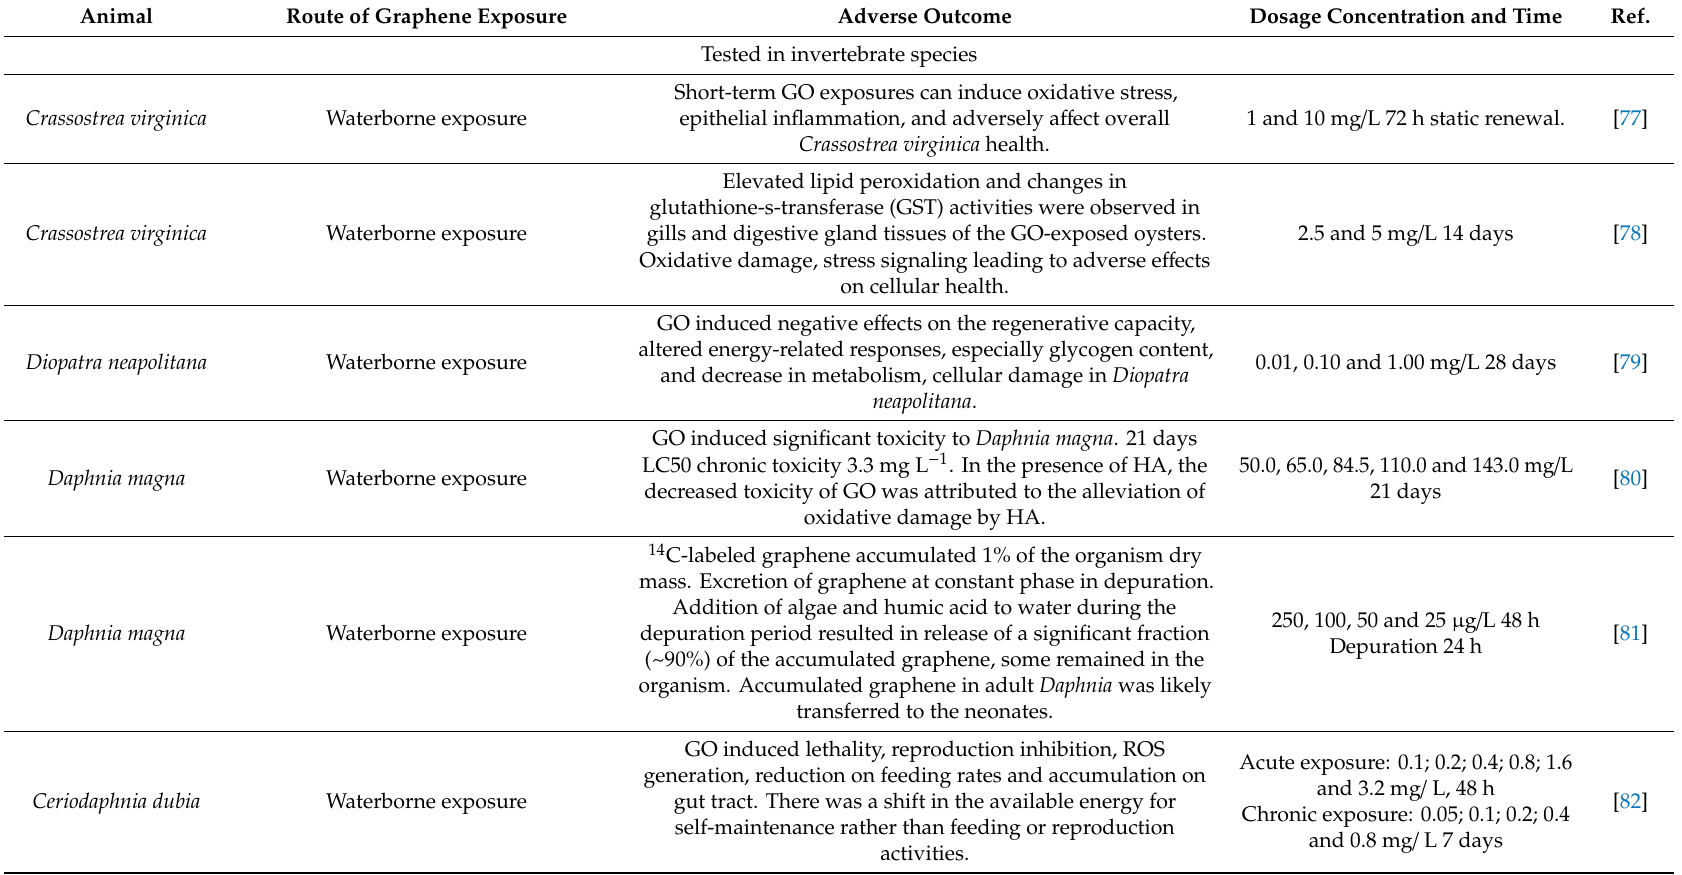
Table 1. Summary of graphene and graphene oxide (GO) toxicity in aquatic animals. Animal Route of Graphene Exposure Adverse Outcome Dosage Concentration and Time Ref. Tested in invertebrate